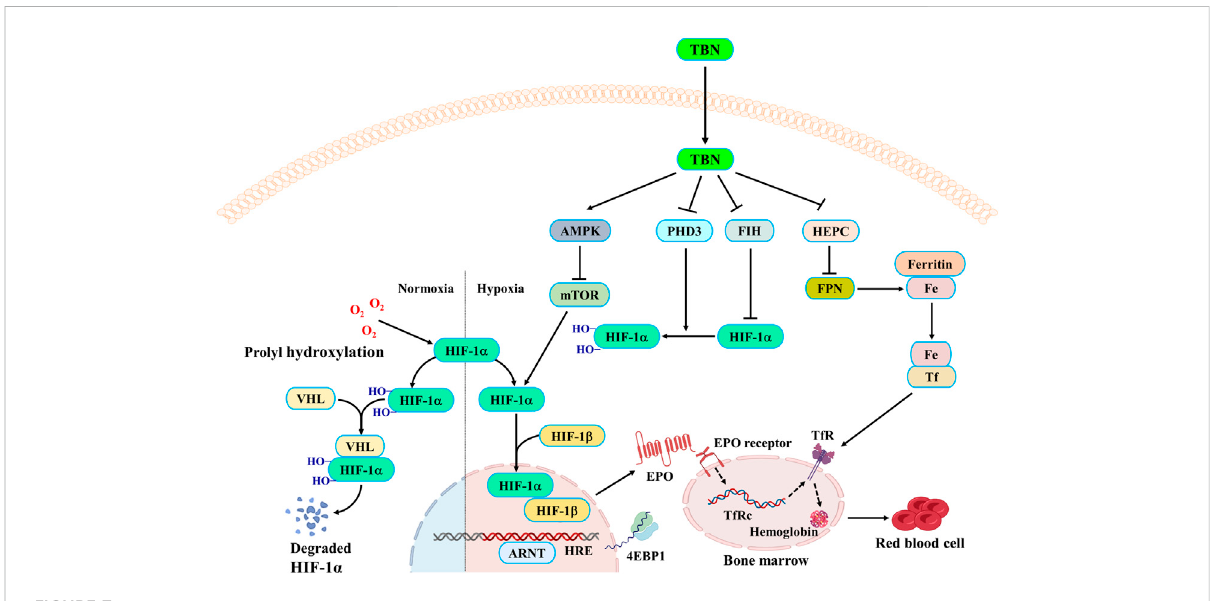
TBN mechanism of action in